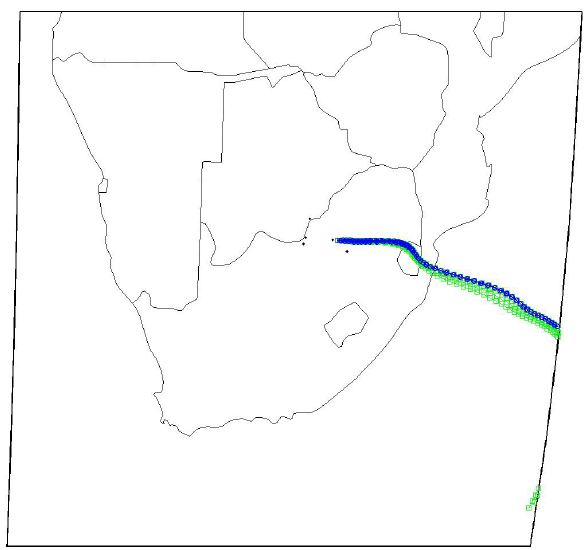
Fig. 3. 96h air mass back-trajectories during the first (green) and second (blue) nucleation and growth event of the day on 21 Novem- ber 2009.